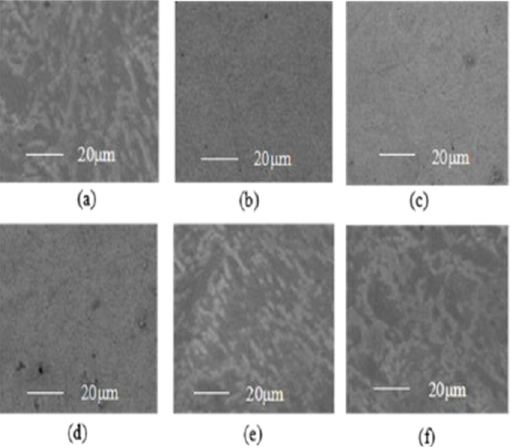
Figure 13. The SEM graph of the Ni coating surface: ( a ) 200 W; ( b ) 100 W; ( c ) 0 W; ( d ) 200 kHz; ( e ) 120 kHz; ( f ) 80 kHz.